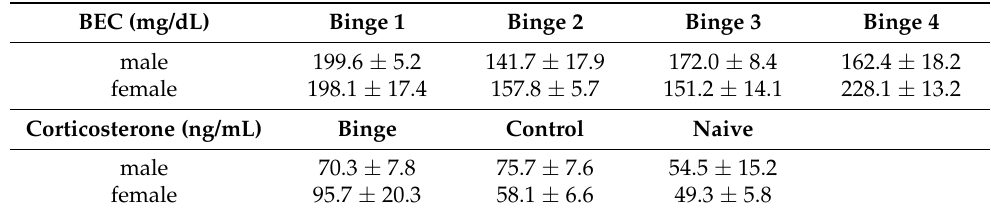
Table 1. Blood ethanol concentrations (BEC) in binged groups across time and corticosterone levels in all groups after final binge exposure.